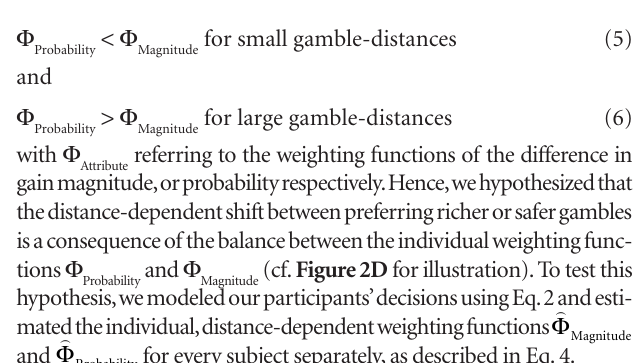
(caudate, − 12, 0, 18 and 9, 0 15) and (C) anterior cingulate cortex (ACC; 3, 18, 27). In the scatter plots, the peak activations in the identified regions of individual participants are regressed against their intransitivity